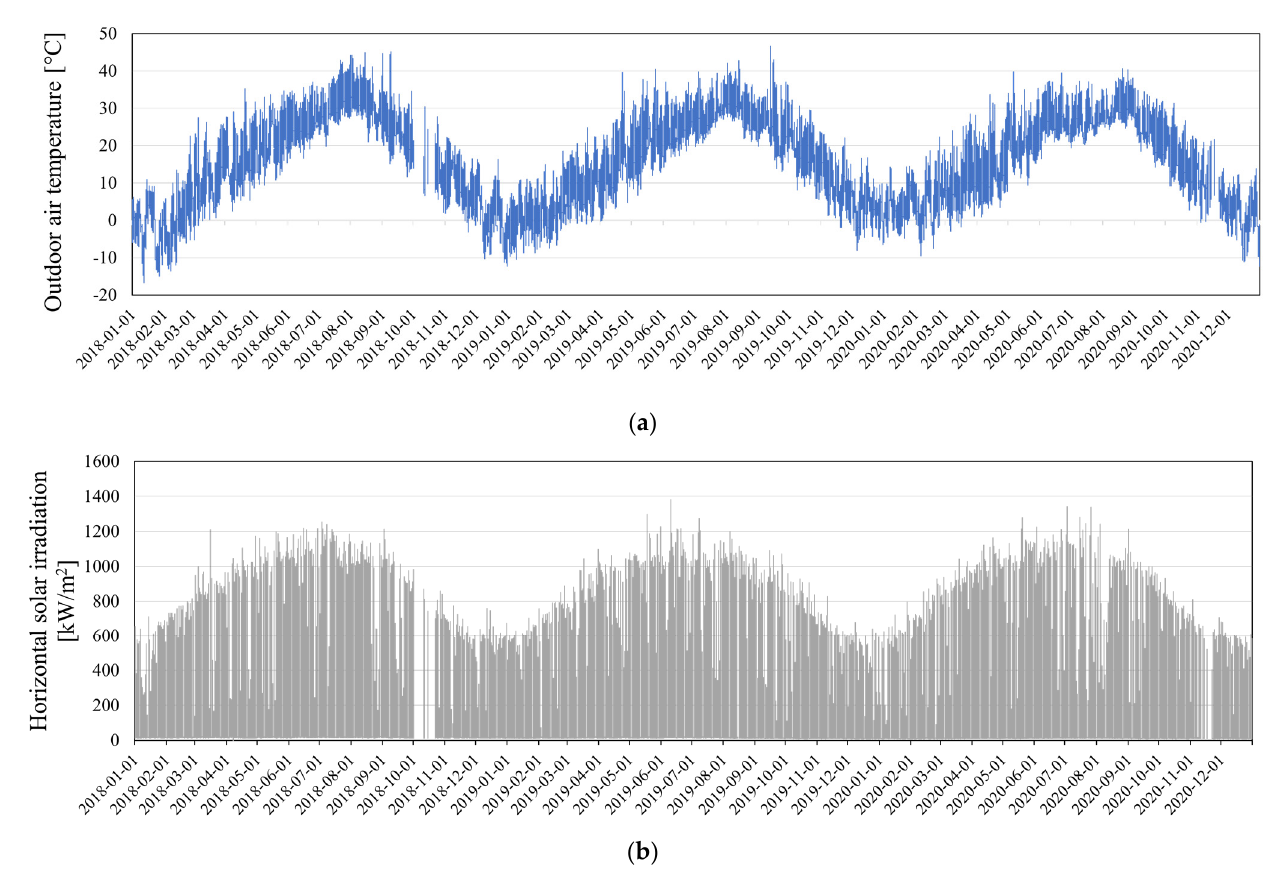
Figure 4. Outdoor air conditions during the test periods: ( a ) outdoor air temperature; ( b ) horizontal solar irradiation.